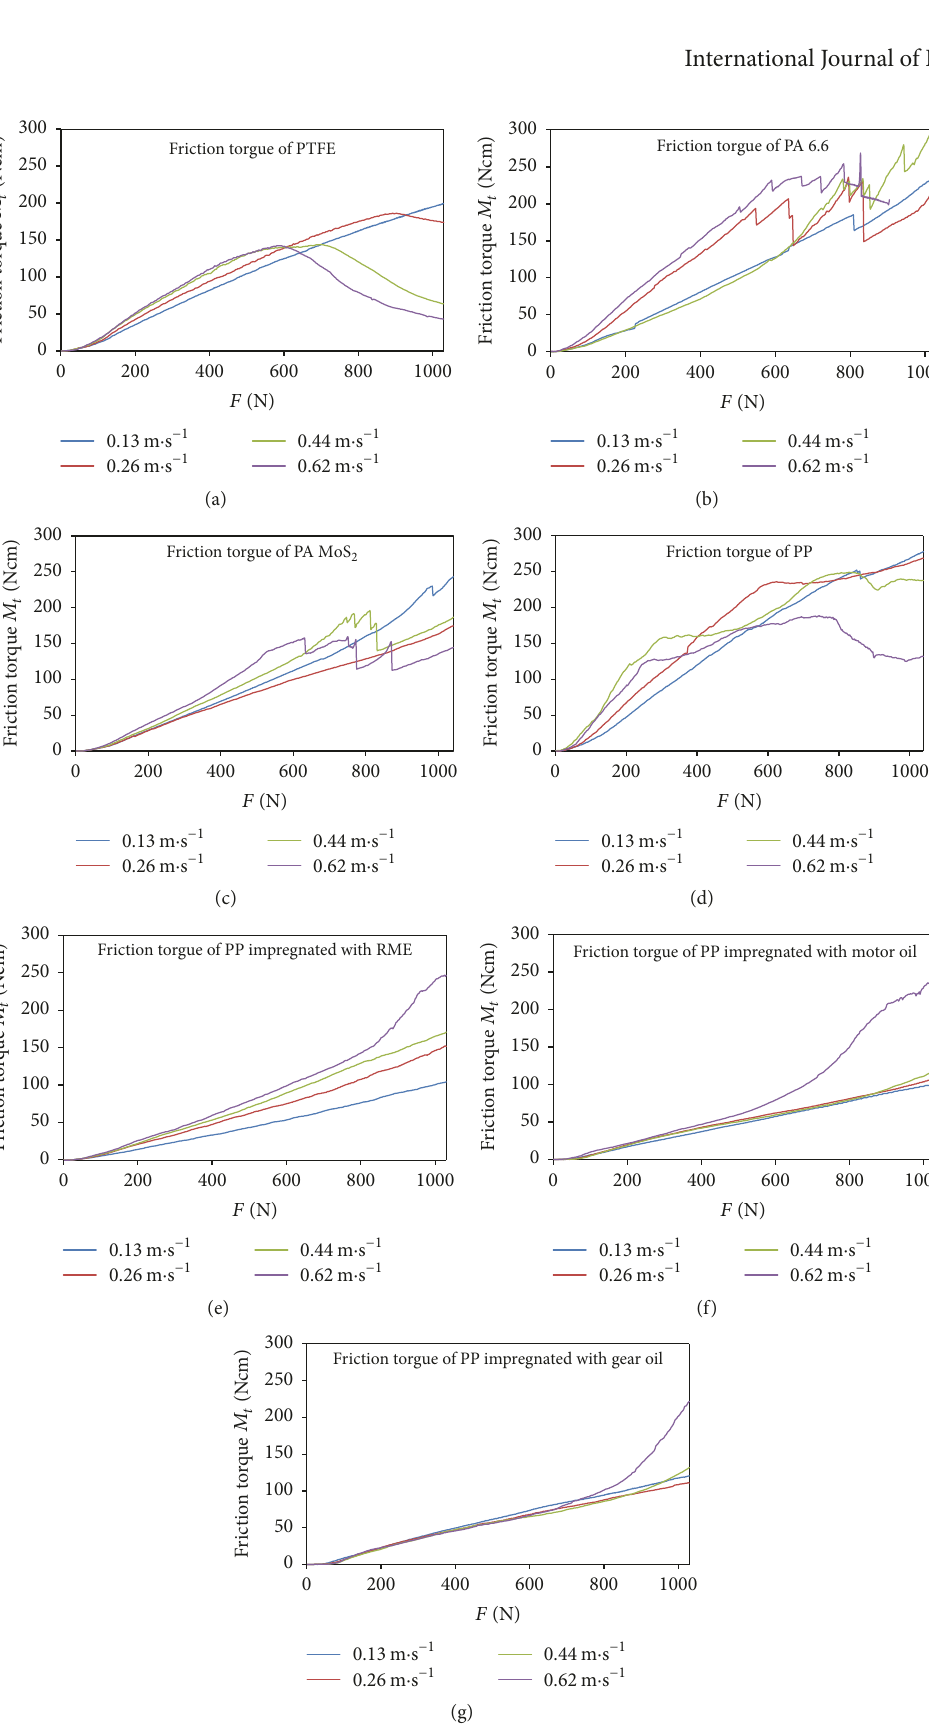
Figure 4: Relationship between sliding distance, load, and friction torque of the samples under various sliding velocities, 0.13, 0.26, 0.44, and 0.62 m ⋅ s −1 , for (a) PTFE, (b) PA 6.6, (c) PA MoS 2 , (d) unmodified PP, (e) PP impregnated with RME, (f) PP impregnated with engine oil, and (g) PP impregnated with gear